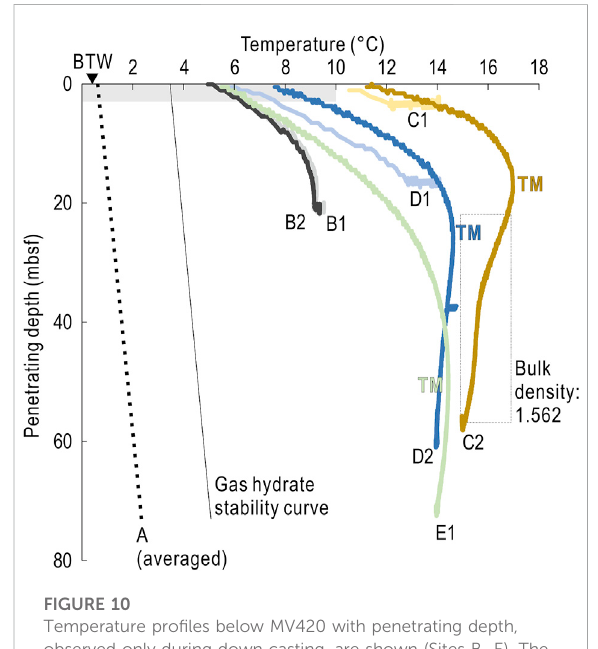
FIGURE 10 Temperature pro fi les below MV420 with penetrating depth, observed only during down casting, are shown (Sites B – E). The temperature value refers to the average of all MTL temperature readings atdepth. Based on thetemperature pro fi le,thelocal temperature maximum is identi fi ed (TM). The depth of the maximum local temperature varies with the sites. The range of the earlier heat fl ow observation (Riedel et al., 2014) is shown as a shaded area. For comparison, an extrapolated thermal pro fi le at Site A as a dashed line and the bottom water temperature (Observation B0) as a triangle are depicted. A dashed area along Observation C2 represents a depth interval for estimation of the bulk density. The gas hydrate stability curve is represented (solid black line) (Vadakkepuliyambatta,